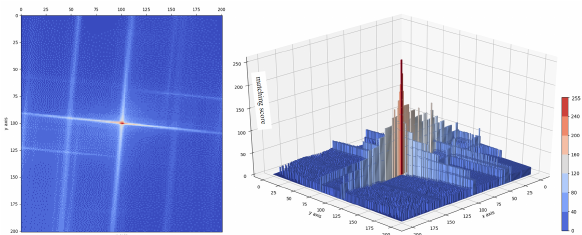
Table 1. Parameters that define the size of a score map resulted from images’ of 50m by 50m with grid cell size 0.05m and border of 5m in each side.